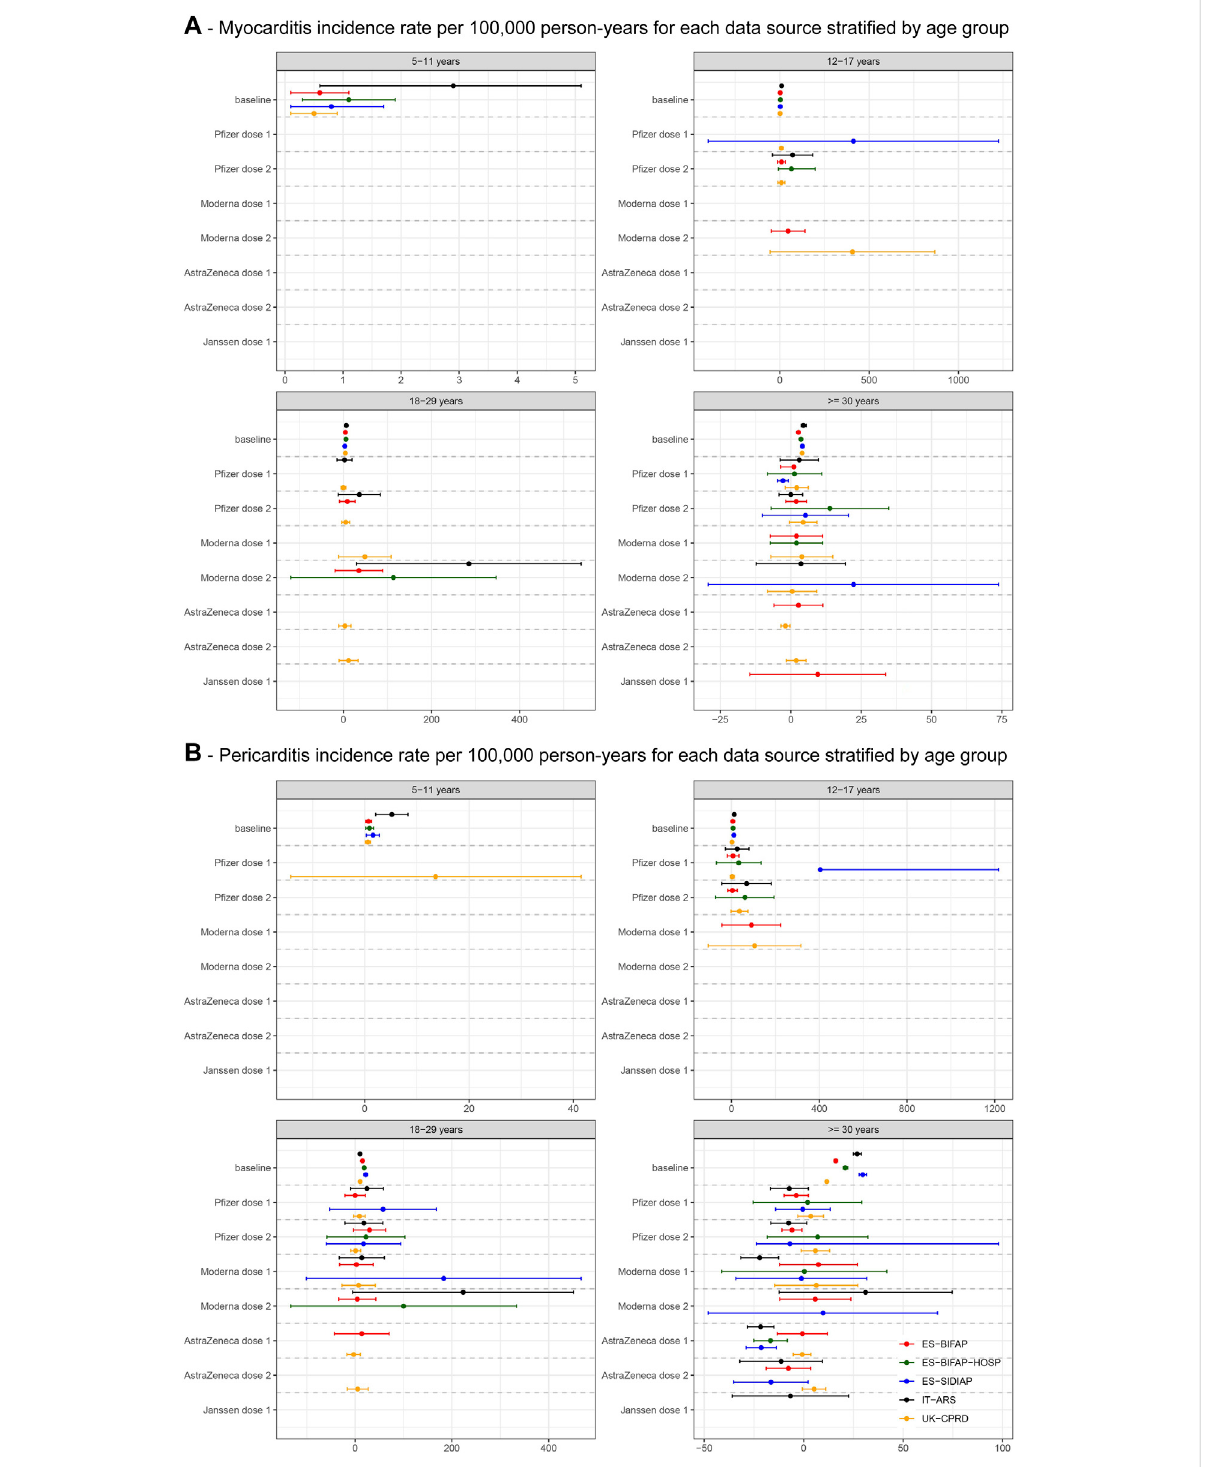
FIGURE 1 The fi gure shows crude incidences for the age categories below 30 years and age-standardised rates for the > = 30 years